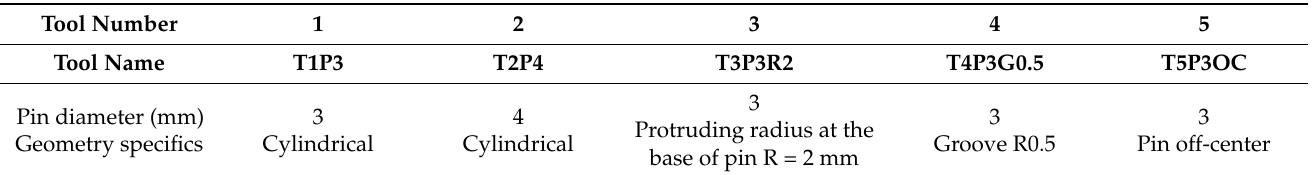
Table 2. Tool design parameters (all tools were of cylindrical shape, had a shoulder diameter of Ø 16 mm, a pin height of 18 mm and a tool length of 50 mm, and were run with a tool tilting angle).